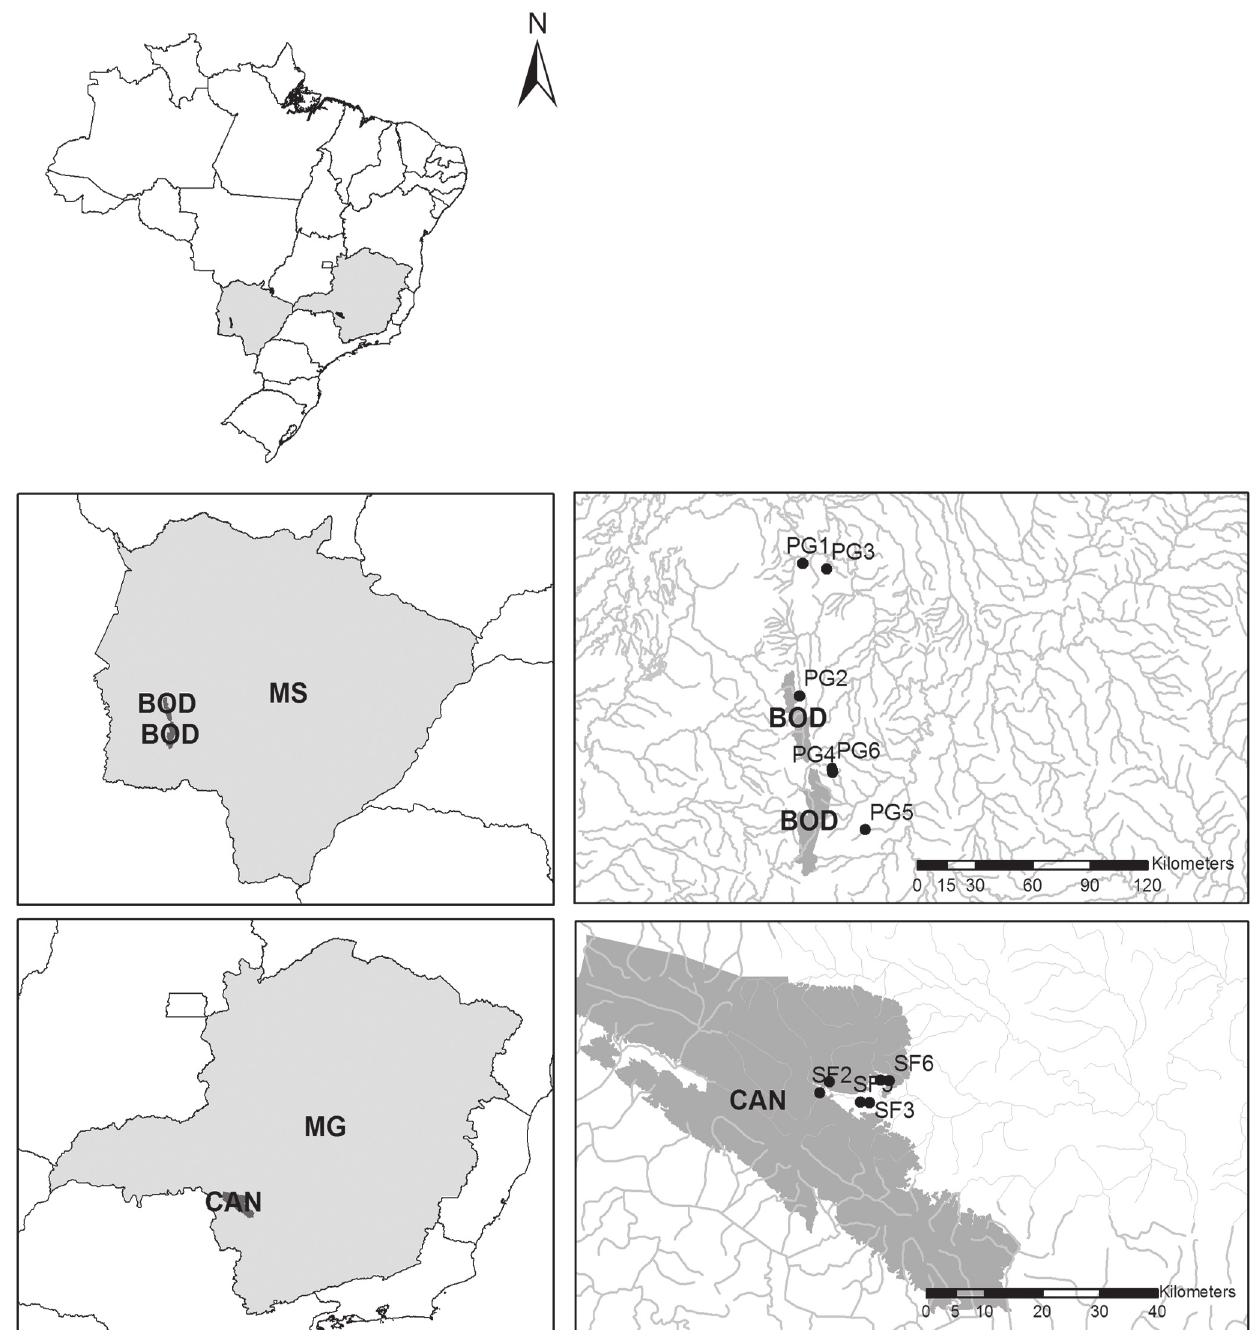
Fig. 1. Study area with the sampling sites at the upper Paraguai and upper São Francisco River basins. BOD: Serra da Bodoquena National Park; CAN: Serra da Canastra National Park; MG: Minas Gerais State; MS: Mato Grosso do Sul State; PG 1-6: sampling locations in the upper Paraguai River basin; SF 1-6: sampling locations in the upper São Francisco River